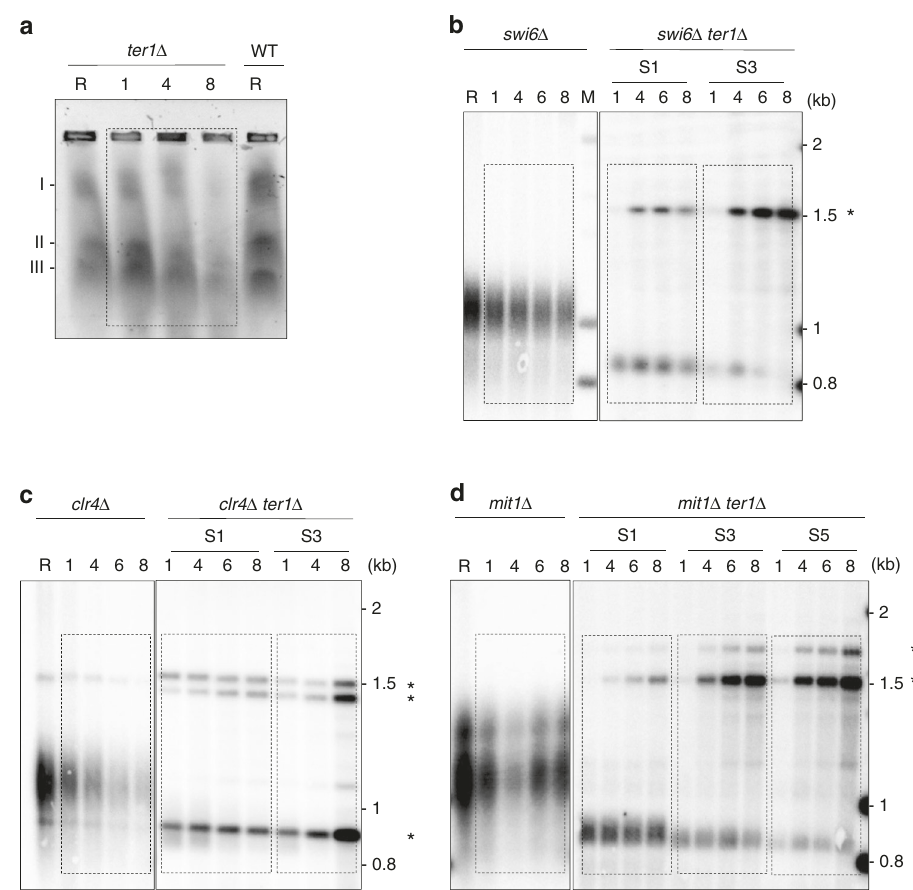
Fig. 5 STEEx formation in quiescent cells does not depend on heterochromatin assembly machinery. a Analysis of STEEx chromosomes by pulsed- fi eld gel electrophoresis. Gel was stained with ethidium bromide. b – d Genomic DNA from quiescent telomerase positive cells and ter1 Δ cells with the indicated genetic backgrounds was digested with EcoR I and southern blotted. Membranes were hybridized with a Telo/STE1 probe. Cells were collected after the indicated days (1, 4, 6, and 8) in quiescence. R shows ter1 + cells collected during replicative growth. STEEx are shown by